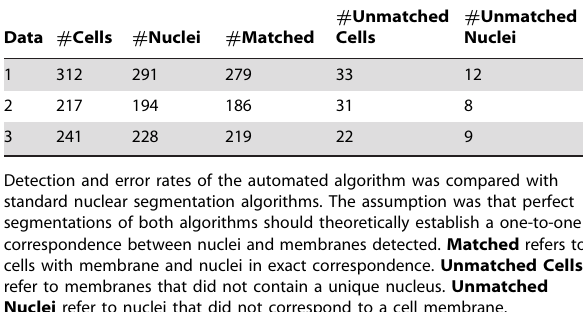
Table 4. Robust correspondence of automated membrane segmentations with automated nuclear segmentations.